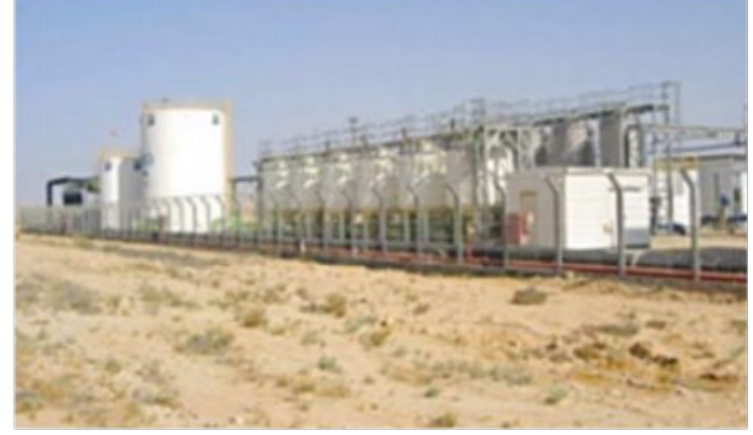
Figure 8. Desalination plant in the Negev Desert.